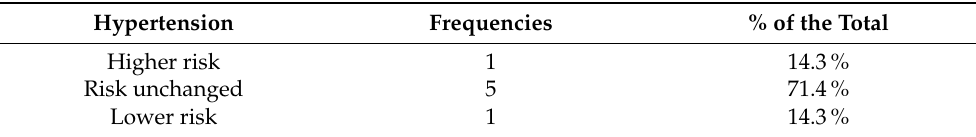
Table 4. Articles grouped by findings concerning hypertension as a risk factor for biological compli- cations of dental implants.